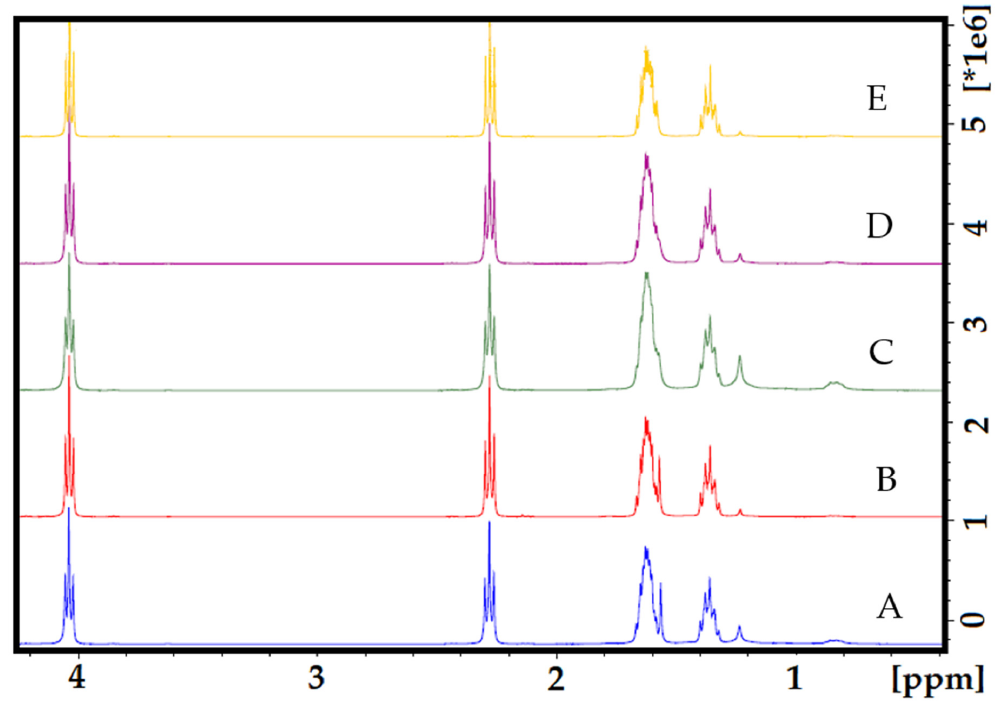
Figure 4. The stack of 1 H NMR spectra of electrospun nanofibers. ( A ) PCL control; ( B ) PCL-CUR1; ( C ) PCL-CUR2; ( D ) PCL-CUR3; ( E ) PCL-CUR4.